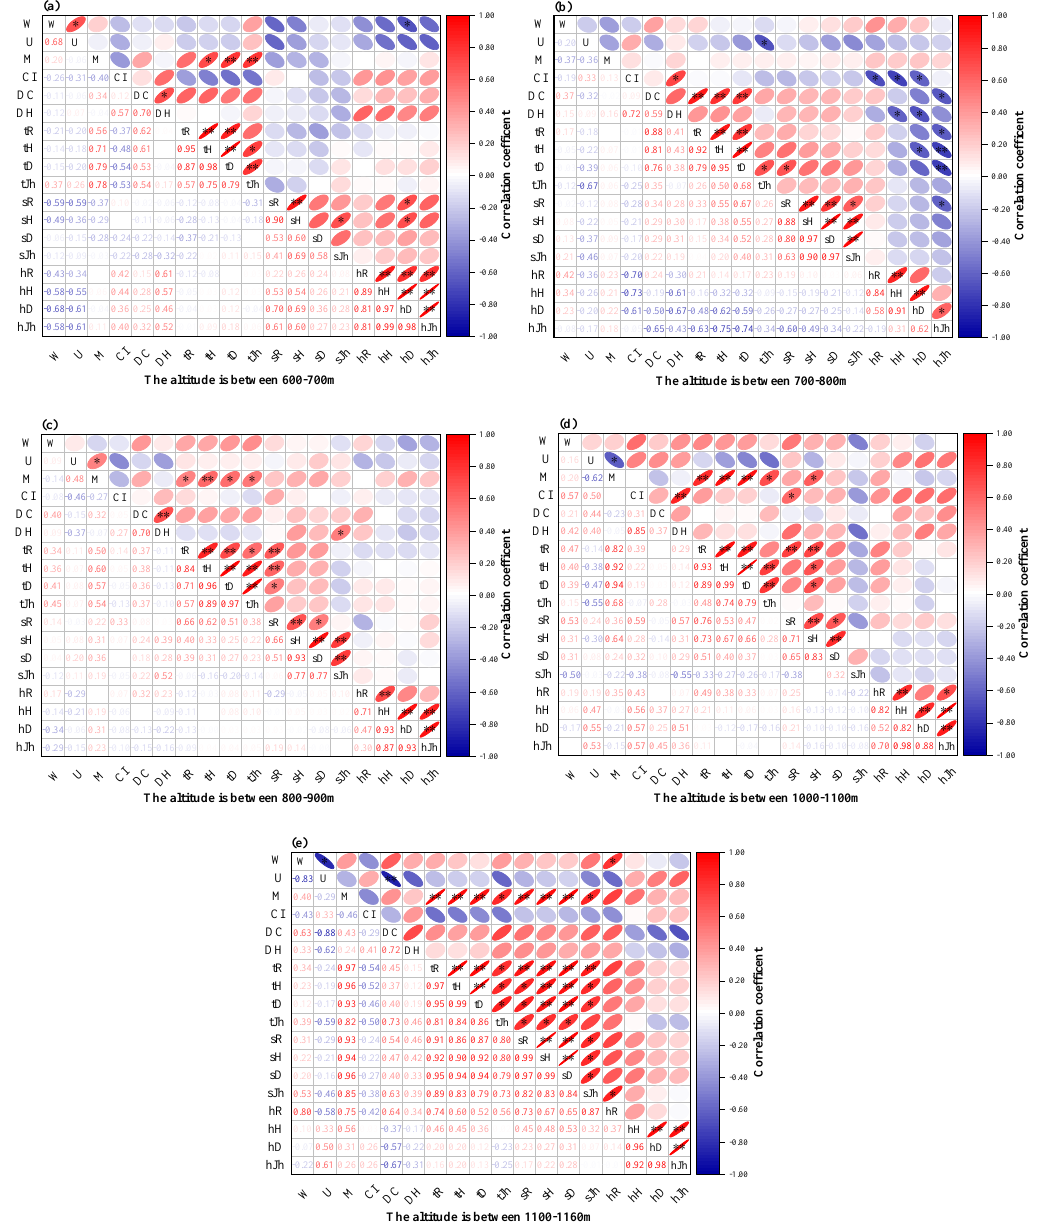
* p<=0.05 ** p<=0.01 Figure 6. Relationship between plant community structure and species diversity in different altitude gradients. ( a ) The altitude is between 600 – 700 m; ( b ) the altitude is between 700 – 800 m; ( c ) the altitude is between 800 – 900 m; ( d ) the altitude is between 1000 – 1100 m; and ( e ) the altitude is between 1100 – 1160 m.